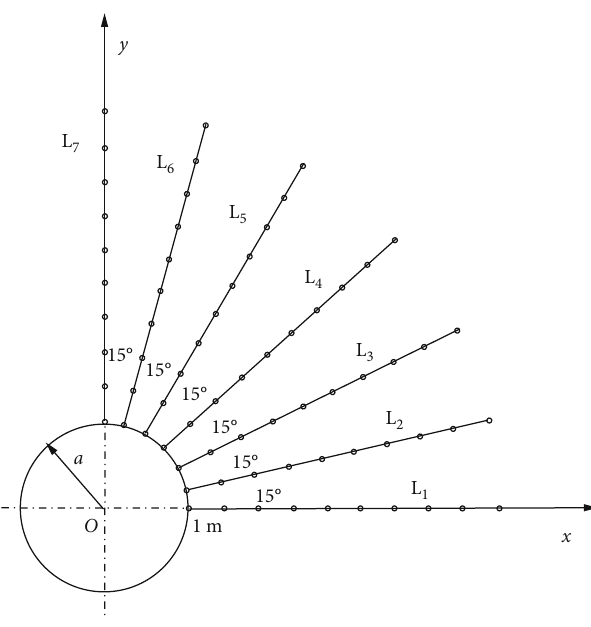
Figure 3: Arrangement for measuring points.